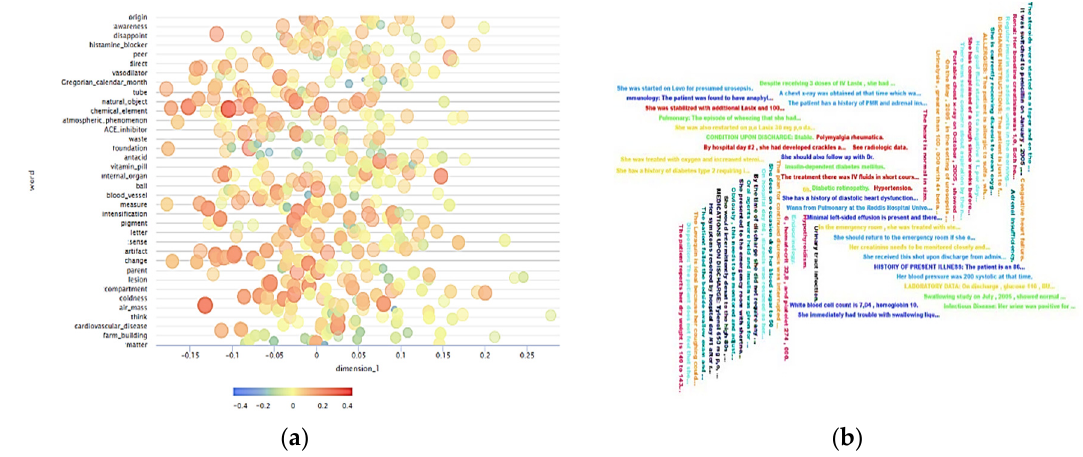
Figure 2. ( a ) Words presentation based on the vector, and ( b ) sentence presentation based on the